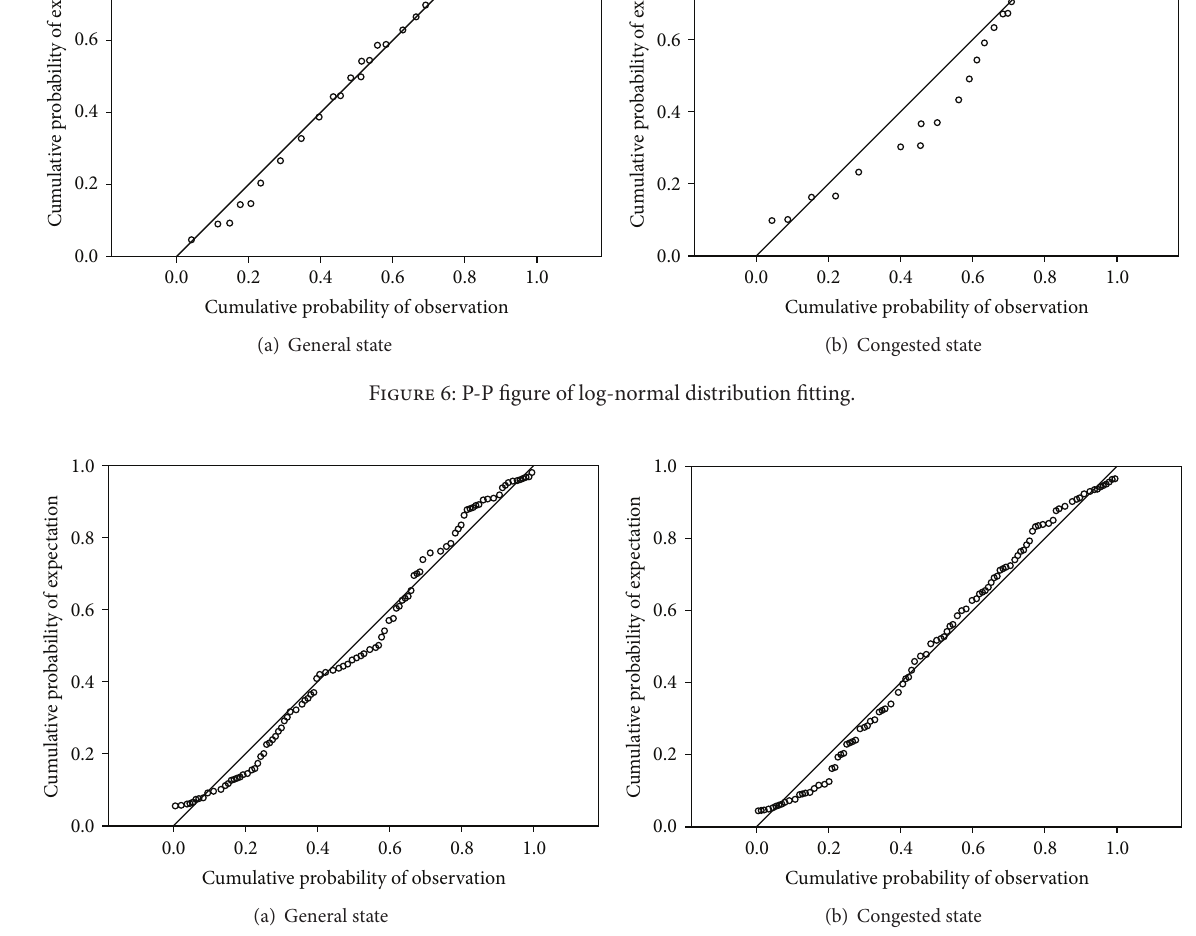
Figure 7: P-P figure of normal distribution